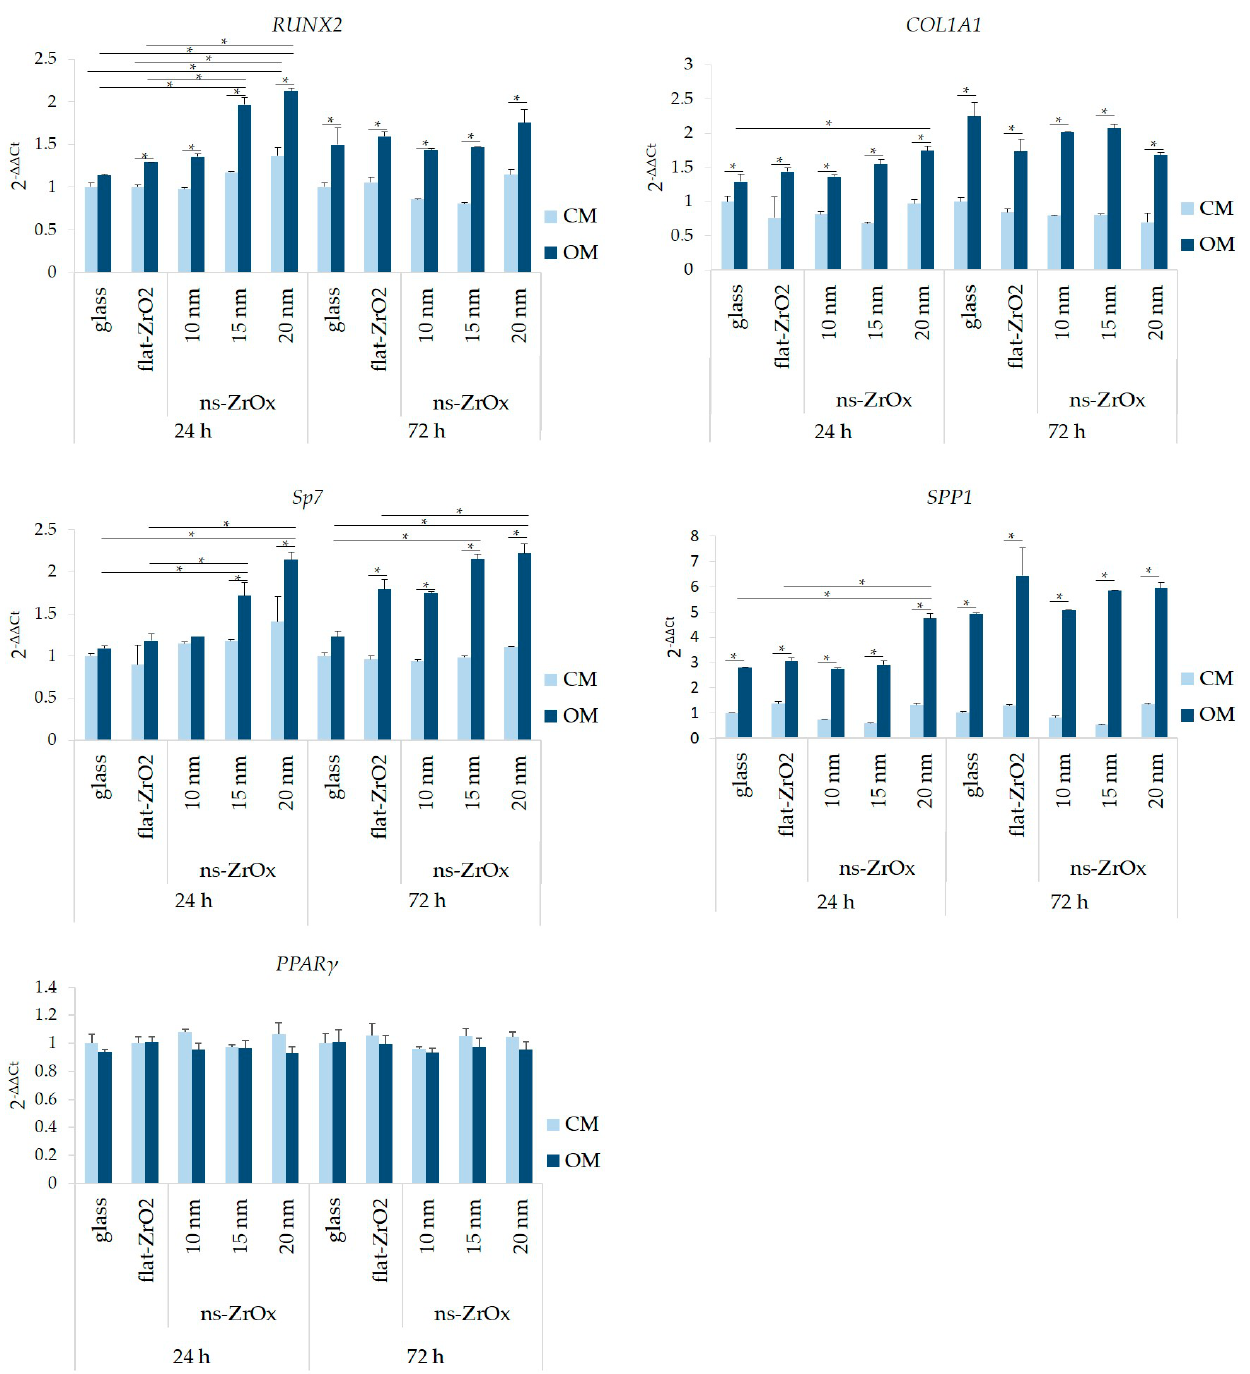
Figure 3. The effects of nanostructured zirconia substrates on bMSC differentiation. RT-PCR was performed on RNA extracted from bMSCs cultured in CM or OM for 24 and 72 h on ns-ZrOx (20 nm), flat-ZrO 2 , and glass using primers designed on RUNX2 , COL1A1 , Sp7 , SPP1 , and PPAR γ sequences. * p ≤ 0.05.